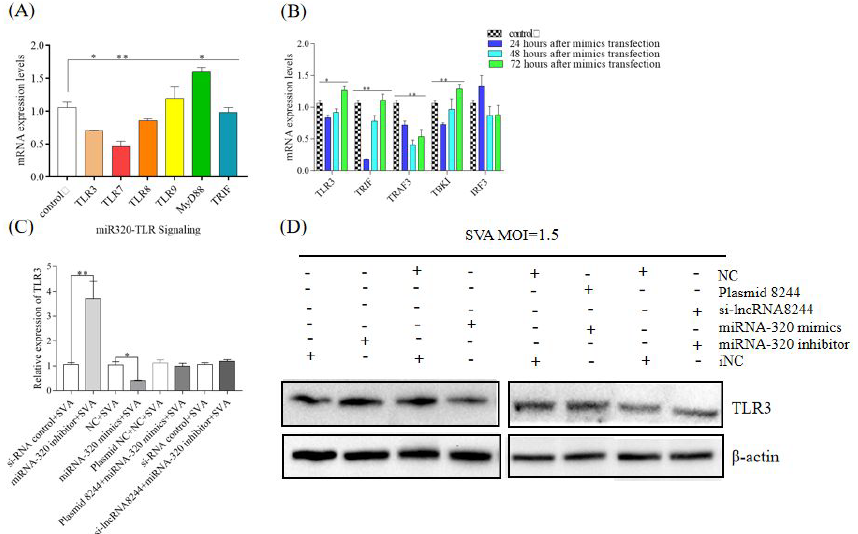
Figure 6. MiR-320 can down-regulate the expression of key molecules in the TLR signaling pathway. ( A ) The expression of TLR3/TLR7/TLR8/TLR9/MyD88/TRIF. ( B ) The expression of TLR3/TRIF/TRAF3/TBK1 and IRF3. ( C ) The expression of TLR3 was determined by real-time RT-PCR assay or Western blot ( D ). The mRNA level of TLR3 was normalized to the mRNA level of GAPDH, and anti- βactin was used as a control for Western blot sample loading. All data are represented as mean ± SD with three replicates. * p < 0.05; ** p < 0.01.